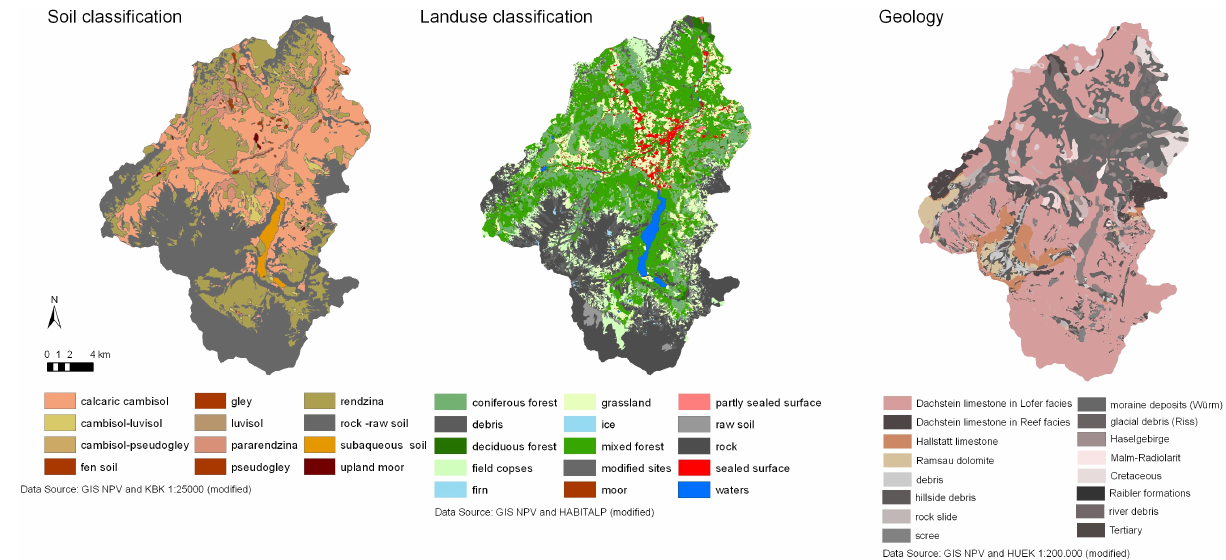
Fig. 3. Soil classification, land use classification and main geological units within the study